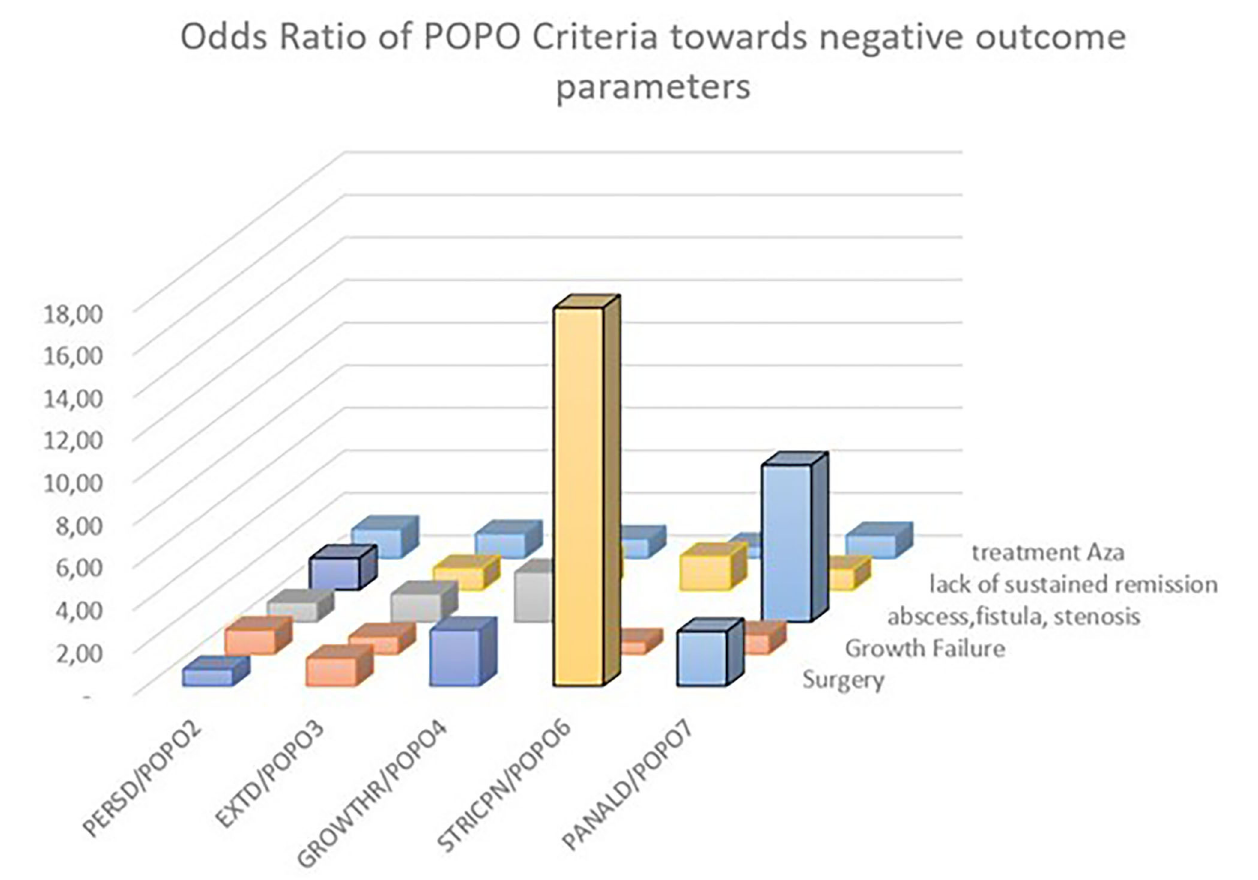
FIGURE 3 | Odds ratio of POPO toward negative outcome parameters. Statistically significant OR 95% CI are marked by bold contours; OR for growth retardation/persistent growth failure 51.16 [19.89–131.62] and stricturing/penetrating behaviour/abscess fistula stenosis 276.31 [37.82–2018.97] were removed for better